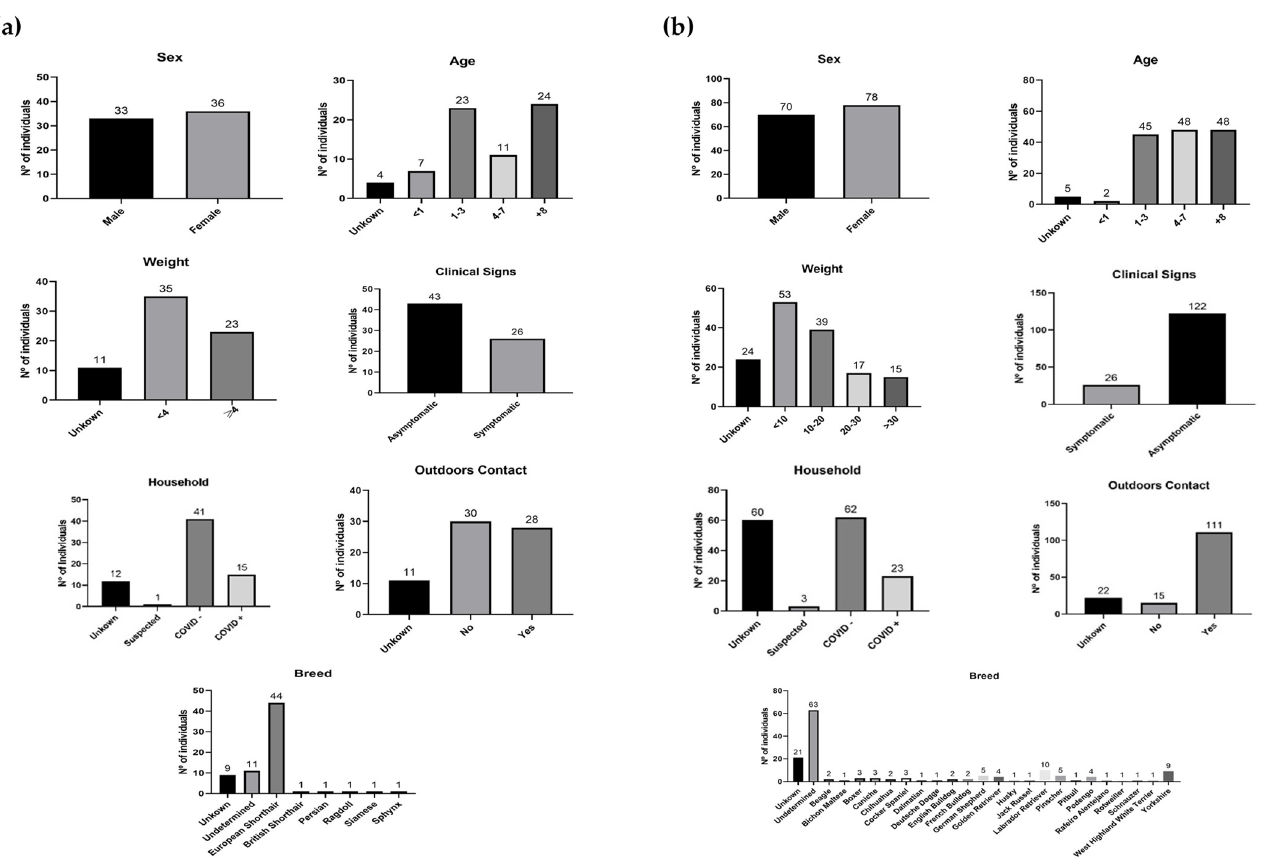
Figure A1. Signalment of ( a ) cats and ( b ) dogs from the SARS-CoV-2 seroepidemiologic study of pets in Portugal.